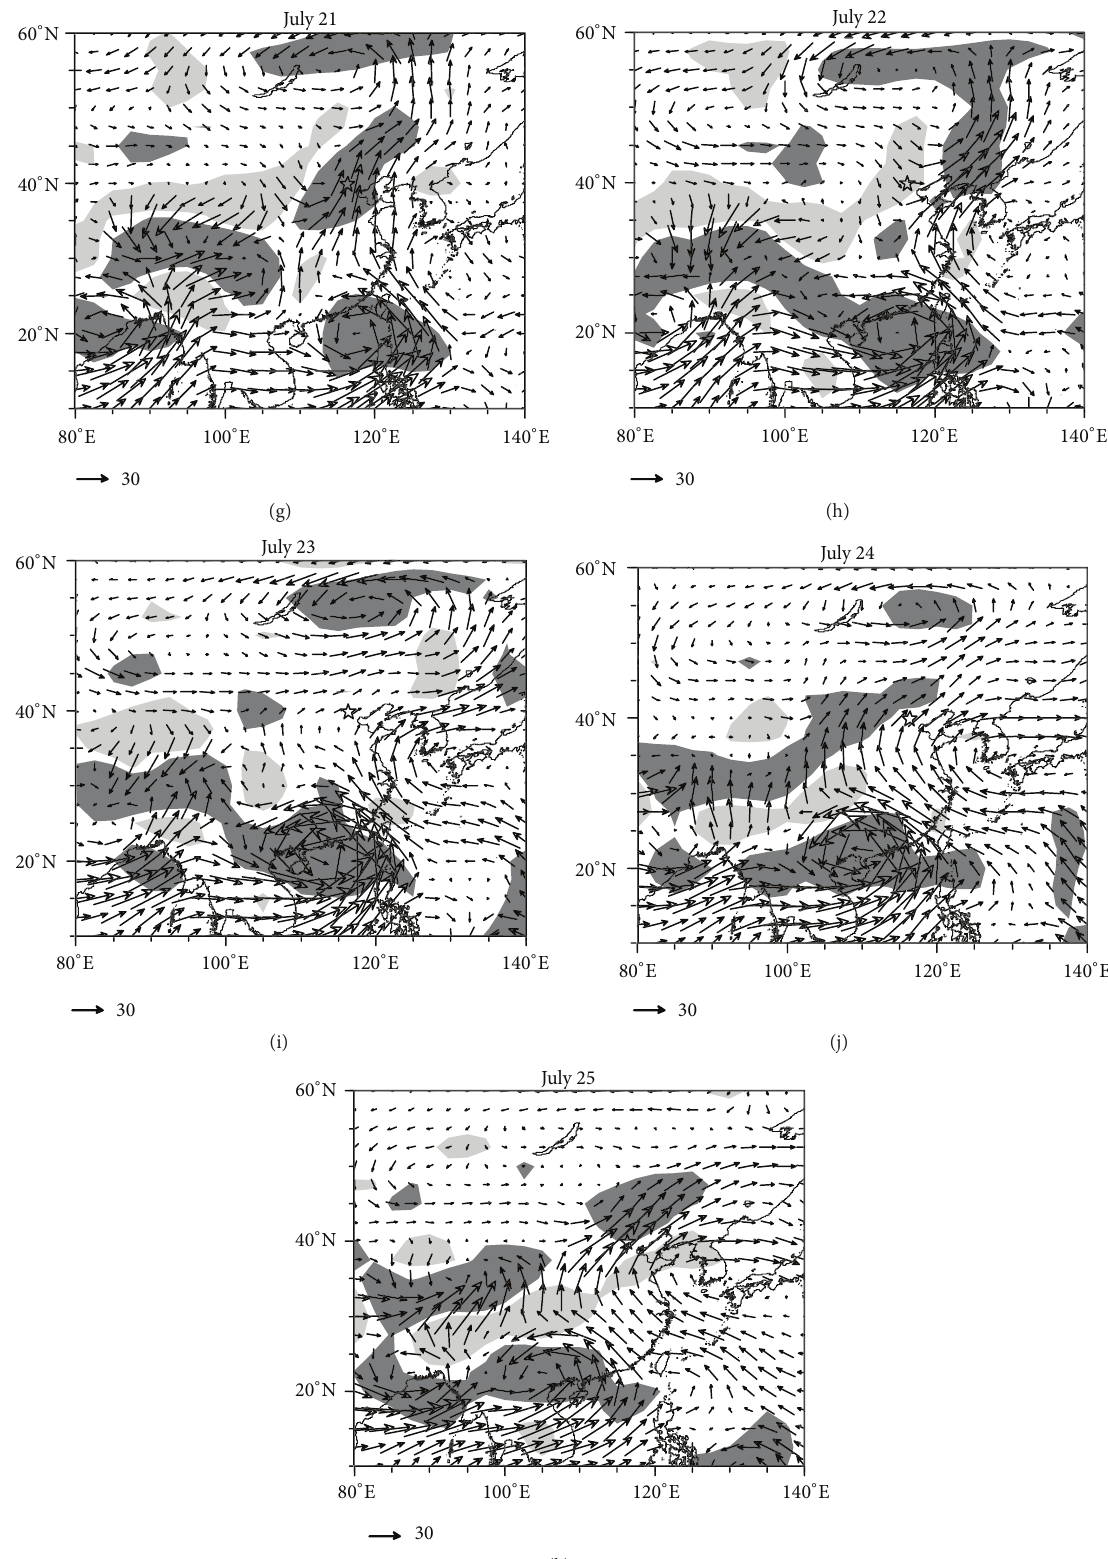
Figure 5: 1000 hpa–100 hpa vapor flux (vector, unit: kg/(s ∗ m)) and water vapor flux divergence (shade: dark color (light color) on behalf of convergence (divergence) where divergence <− 2kg/(m 2 ∗ s) ( > 2kg/(m 2 ∗ s))) for July 15–25 (a–k), 2012. The pentagrams are on behalf of Beijing